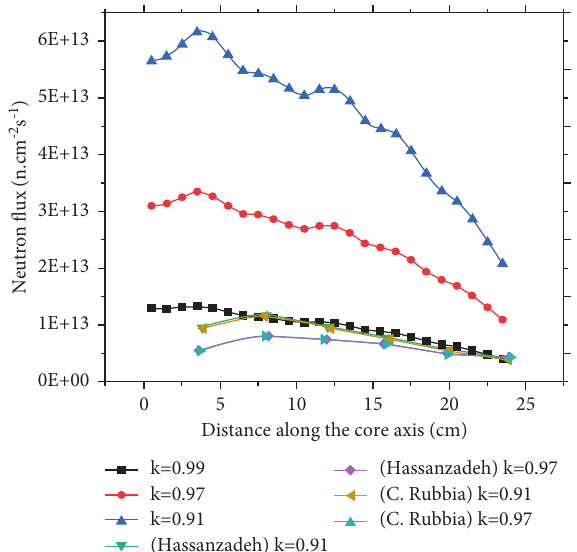
Figure 6: The radial distributions of the neutron flux in the case of ThUO mixture fuel, the molten lead as a target and